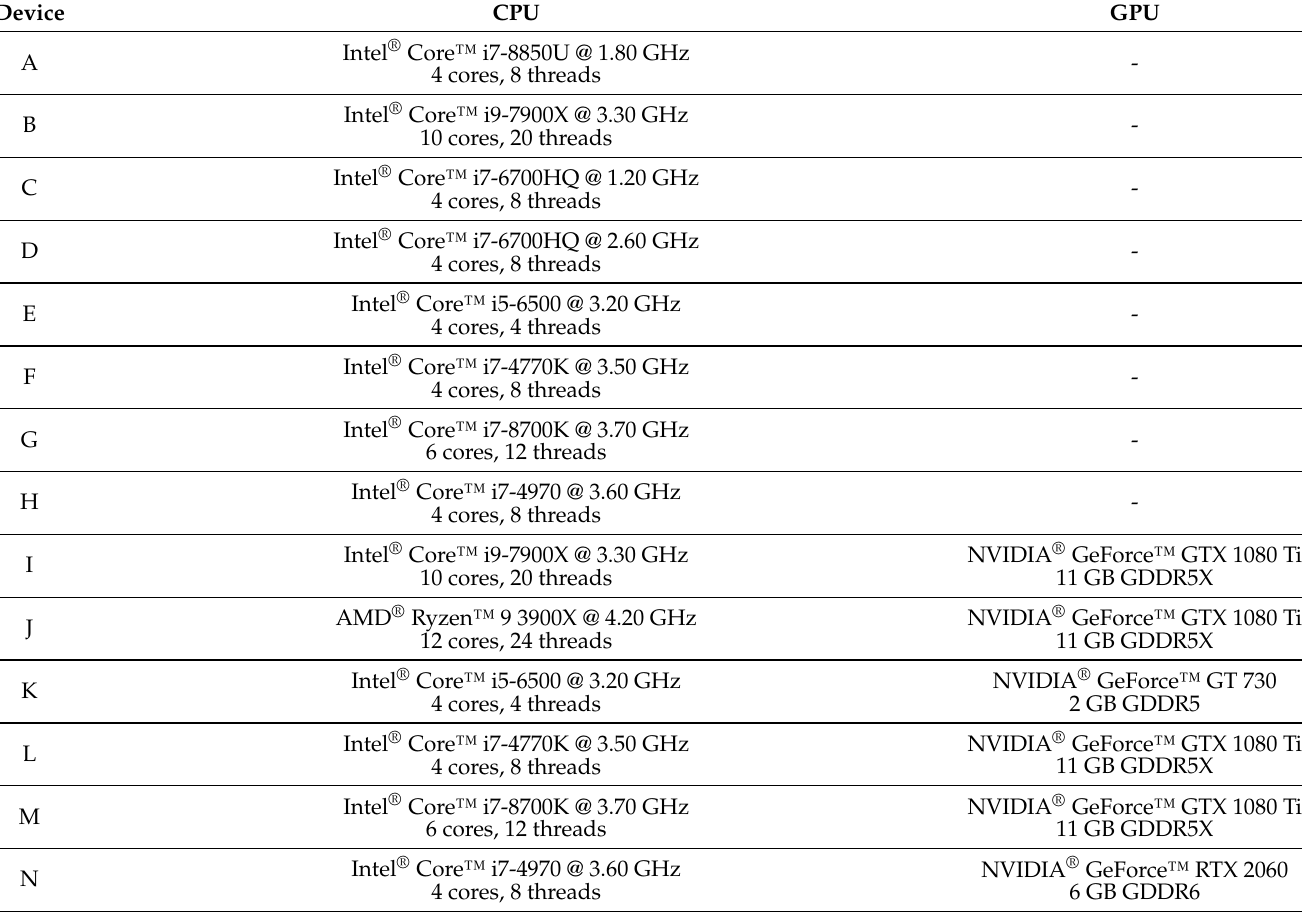
Table A1. Hardware specifications (CPU and GPU) of the different computers used in the PROMETEO evaluation.